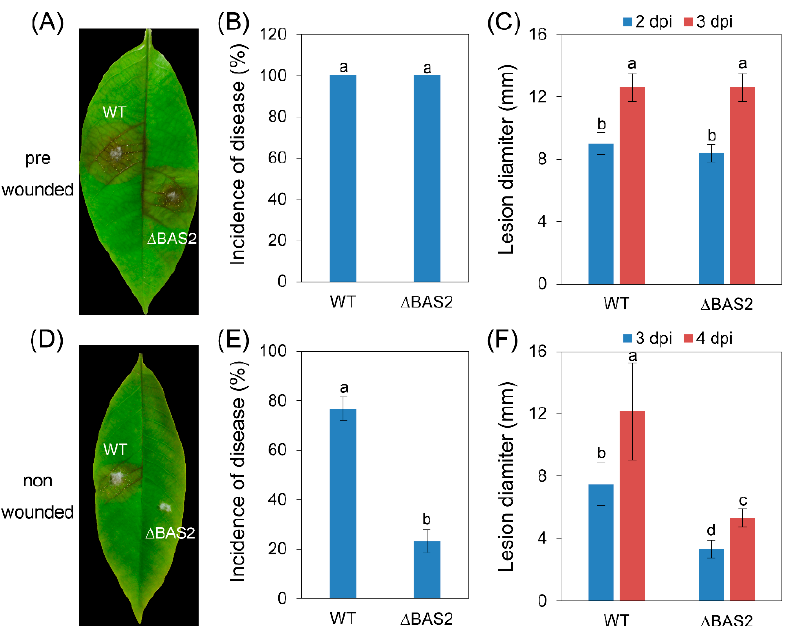
Figure 2. Pathogenicity assay on rubber-tree leaves. ( A , D ) Disease symptoms of rubber-tree leaves at 3 days post-inoculation (dpi). ( B , E ) Mean incidence of disease of rubber-tree leaves at 3 dpi. ( C , F ) Mean lesion diameters after at different dpi. ( A – C ) Rubber-tree leaves were prewounded before the inoculation. ( D – F ) Rubber-tree leaves were nonwounded before the inoculation. Bars represent standard deviation (SD). Columns with different letters indicate significant difference ( p < 0.05).